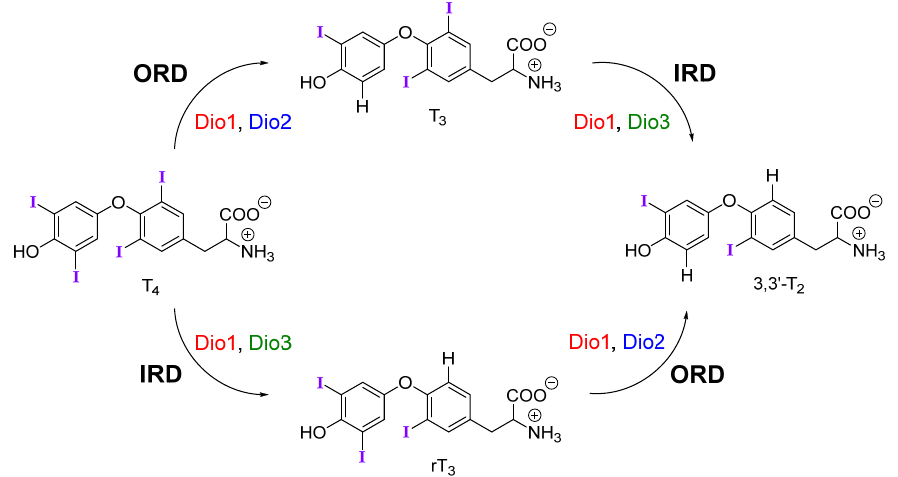
Figure 1. Mechanistic pathways of deiodination by each deiodinase with thyroid hormone (TH) substrates. Dio is regioselective for outer-ring or inner-ring deiodination (ORD and IRD, respectively). PBDEs are used in commercial products to increase flame resistance (Figure 2a) [28,29].